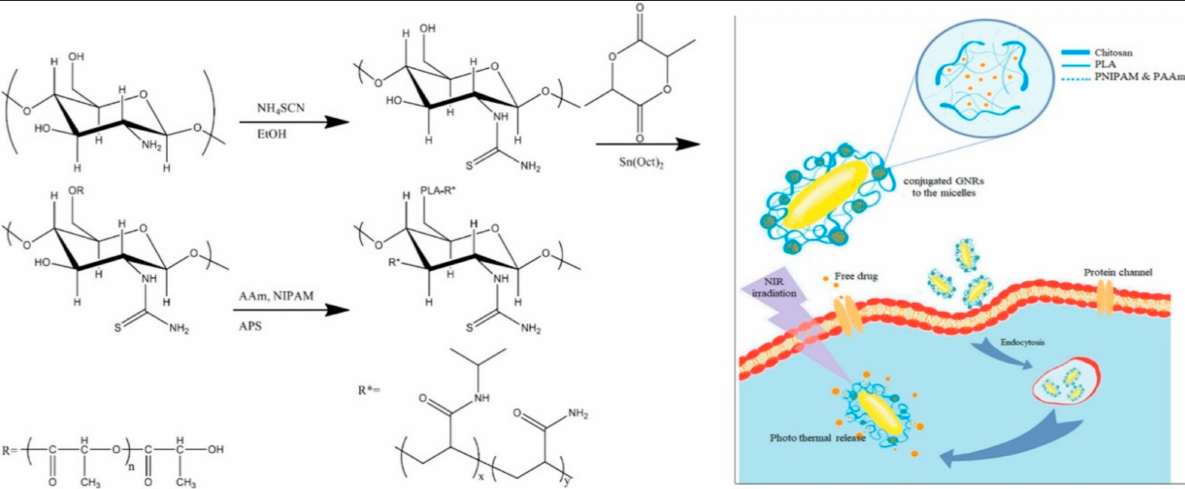
Figure 11. Synthesis process of polymeric micelles of CS-S-PLA-PNIPAM- co -PAAm and light triggered DOX release and imaging for cancer cells using copolymer micelles conjugated Au-NIR probe. Reprinted with permission from [187]. Copyright © 2020,